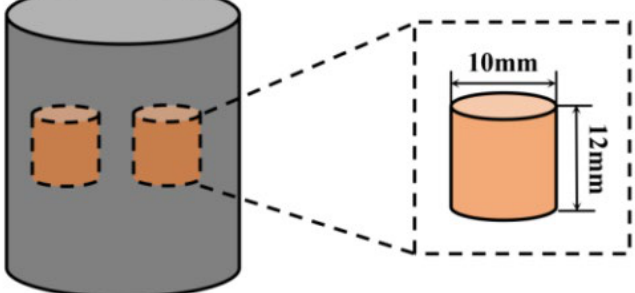
Figure 2. Schematic illustration of compression samples.